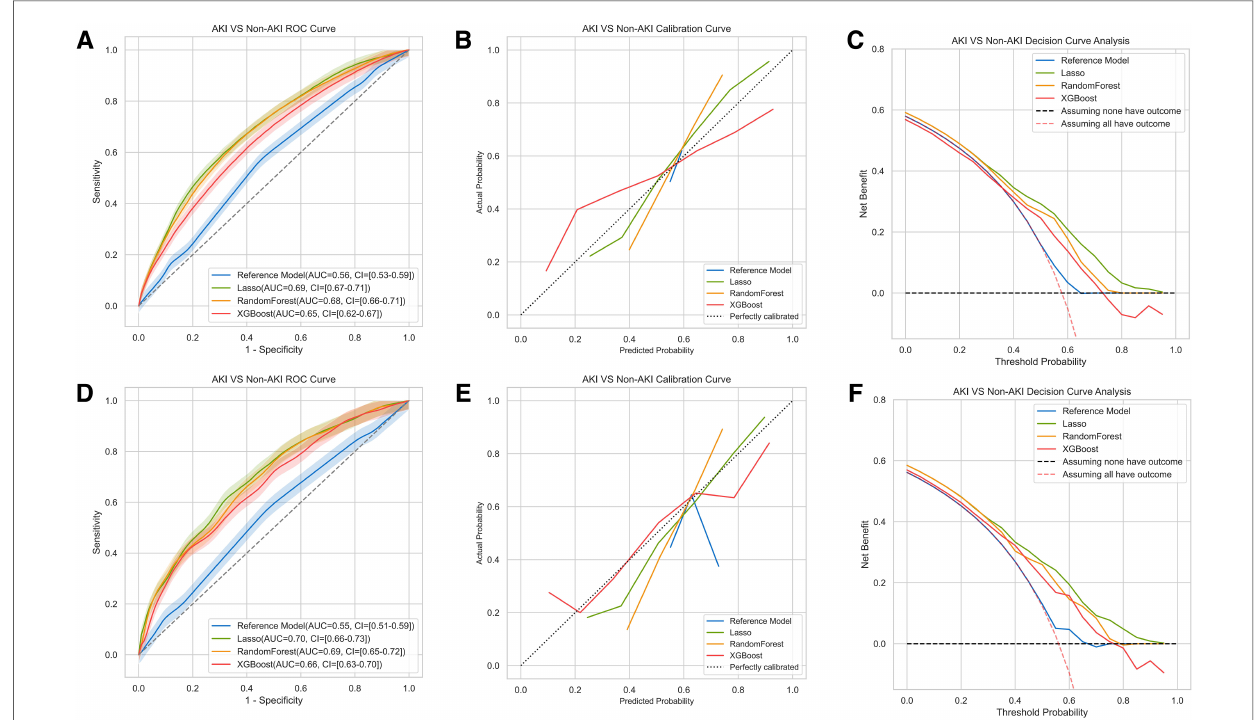
FIGURE 1 Comparison of AUCs, calibration curves and decision curve analysis among different machine learning models for AKI. The results of training set were shown in ( A – C ), testing set in ( D – F ). The model included the LLR model, the XGboost model and the Random Forest model. The reference model was AKICS score in ( A – C